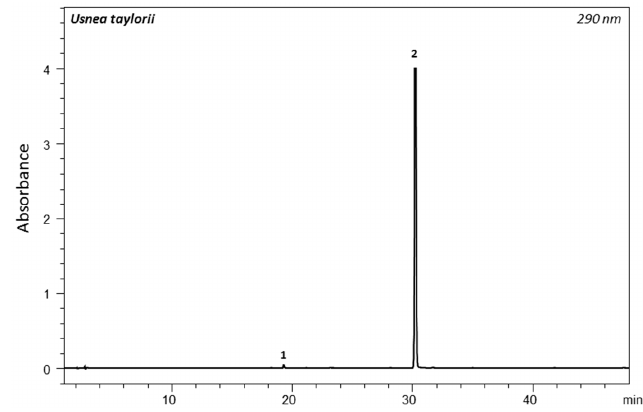
Figure 1. PDA chromatogram at 290 nm of U. taylorii acetone extract. Identified compounds are: (1) fumarprotocetraric acid (traces) and (2) usnic acid.